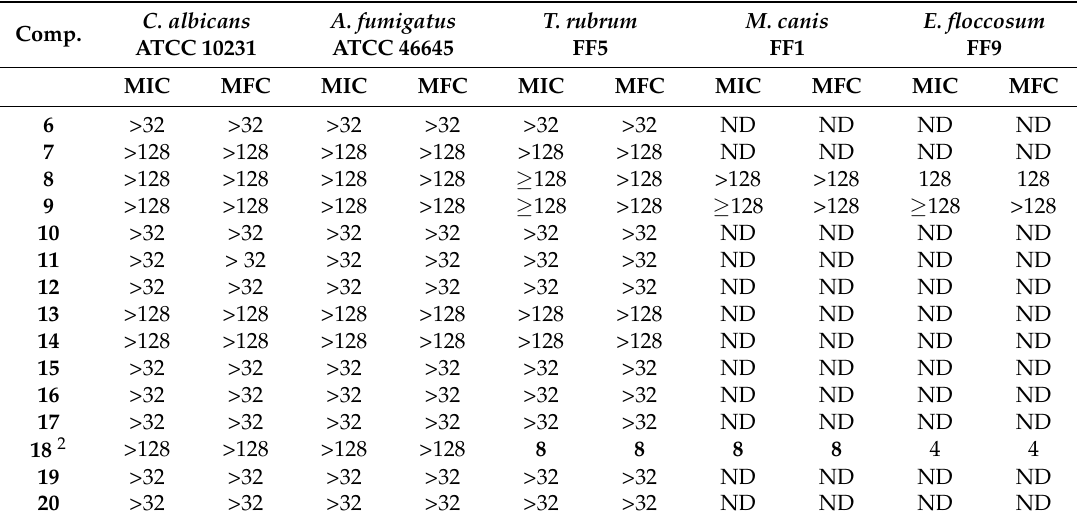
Table 4. Antifungal activity of compounds 6 – 20 . MIC and MFC are expressed in µg/mL 1 . Comp.